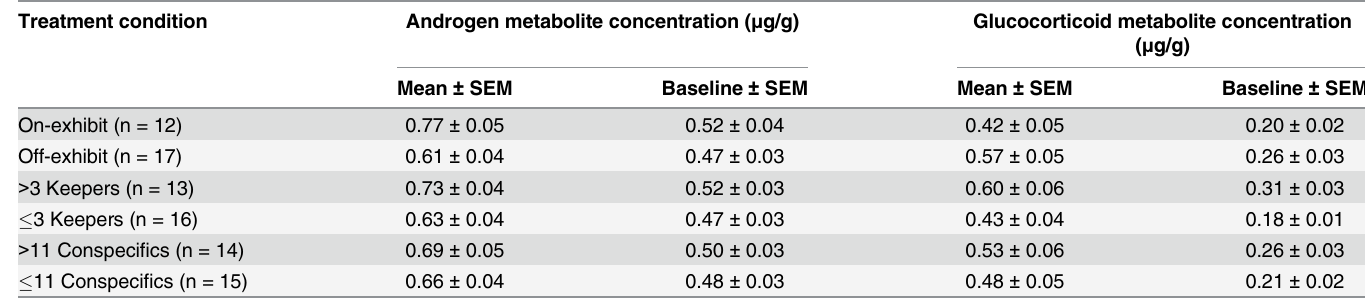
Table 3. Gonadal and adrenal hormone metabolite concentrations for male cheetahs (n = 29) under different treatment conditions. Treatment